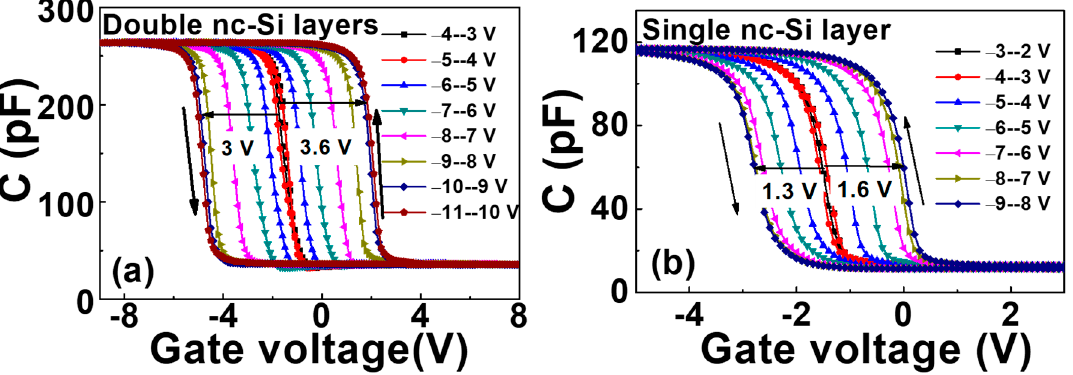
Figure 2. C-V diagrams of ( a ) double-layer nc-Si floating gate memory device and ( b ) single-layer nc-Si floating-gate memory device at 1 MHz.